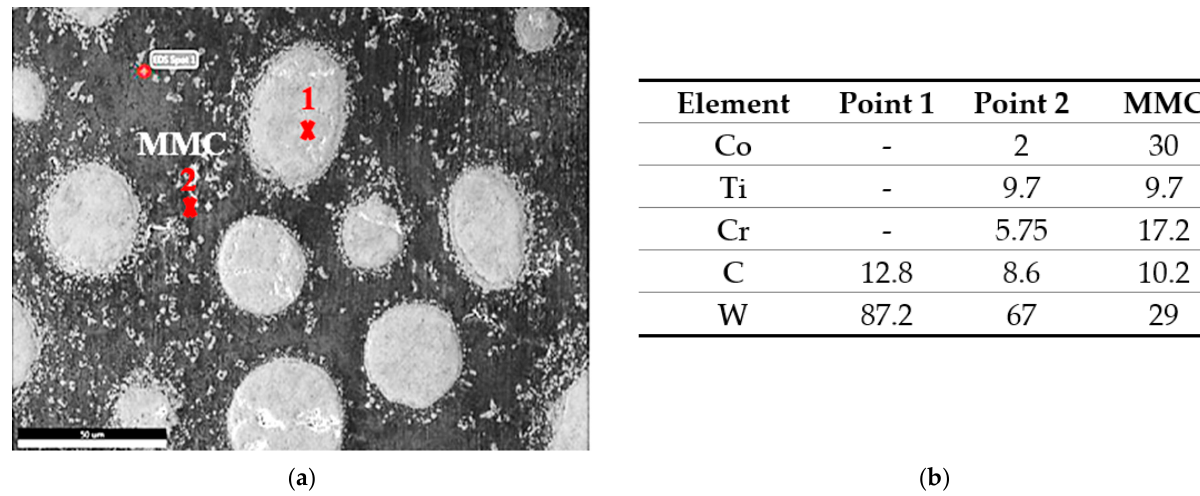
Figure 16. EDAX point analysis results of the deposited layer made with 40% stellite-6 powder + 60% WC: ( a ) SEM micrograph of deposited layer, and ( b ) the chemical analysis of each constituent.